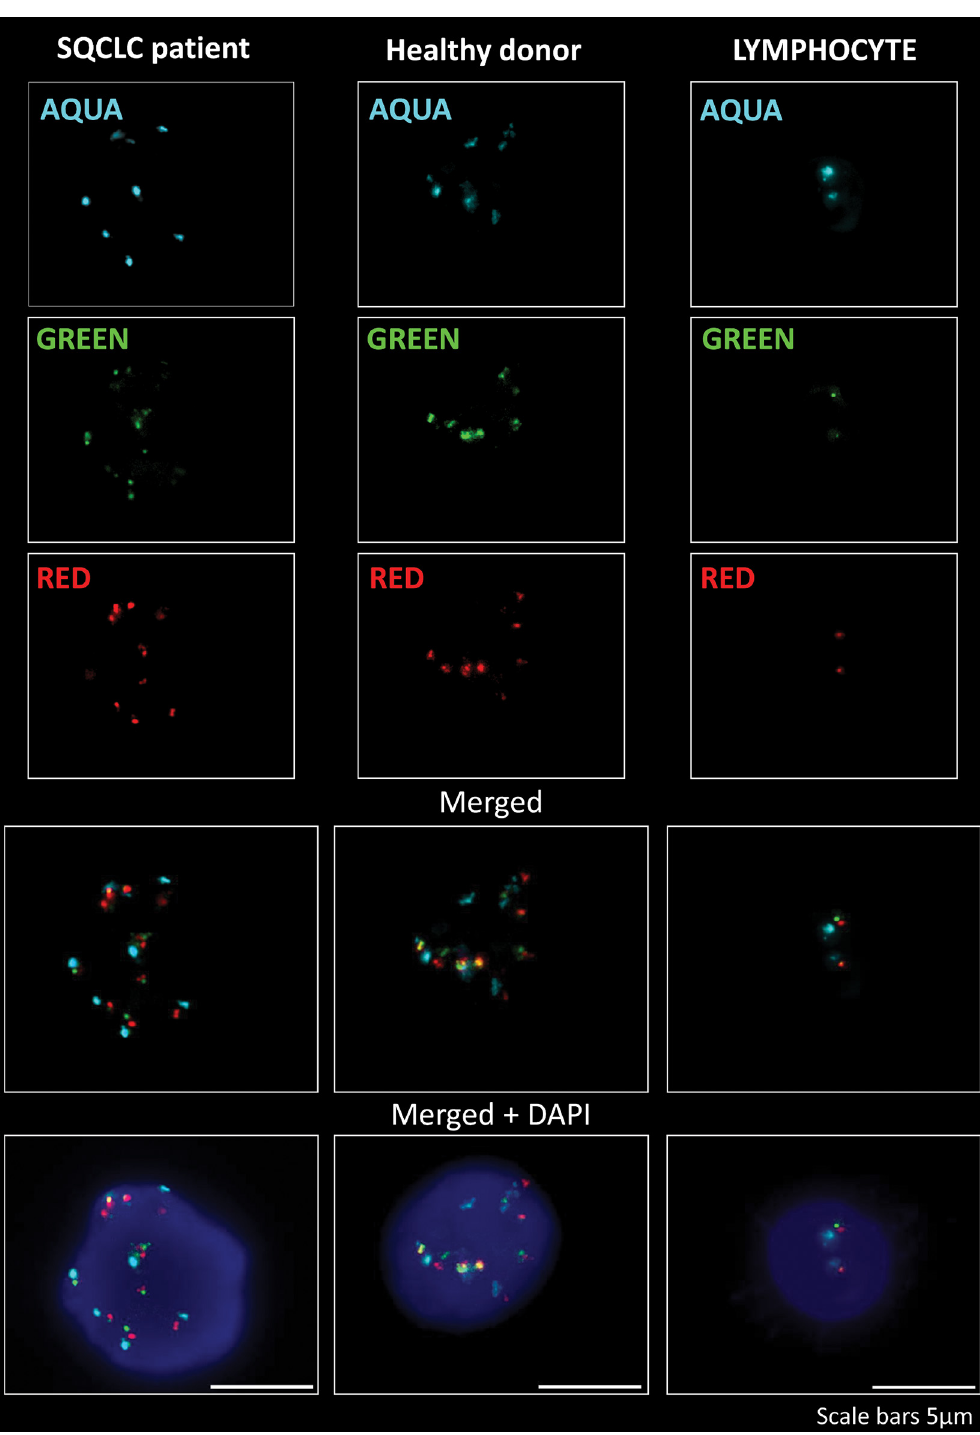
Fig 2. FISH analysis of FGFR1 gene copy number in suspicious circulating elements. Separate acquisitions of aqua signals corresponding to chromosome 8 centromere and green and red signals corresponding to FGFR1 gene copy number in a SQCLC patient and a healthy donor are shown. Aqua, green and red signals are merged alone or in combination with DAPI staining of nuclei. A lymphocyte with normal diploid FGFR1 asset is also shown. Blue fluorescence corresponds to DAPI staining of nuclei. Scale bars = 5 μ m.